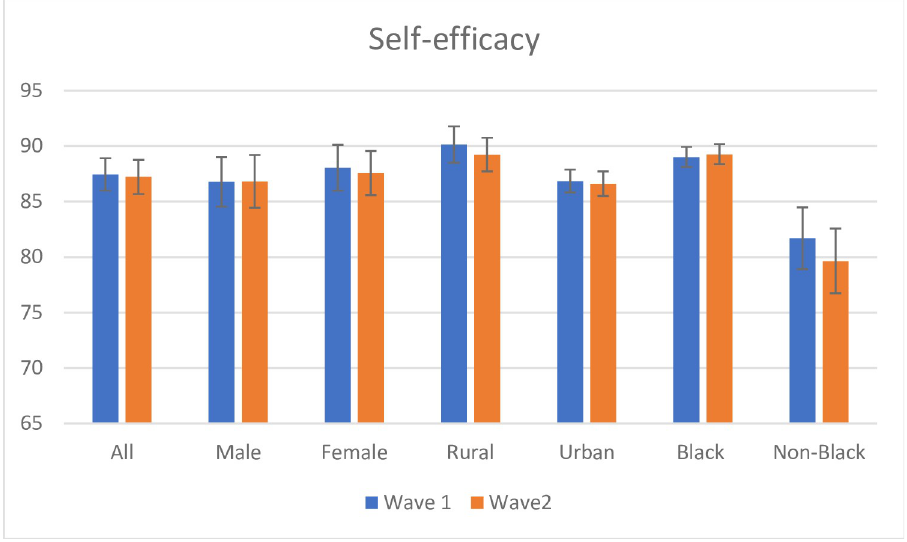
Fig 5. Self-efficacy across Wave 1 and Wave 2. Source: NIDS-CRAM, Wave 1 (2020) and NIDS-CRAM, Wave 2 (2020). Data are weighted. The bars show the reported self-efficacy. 95% confidence intervals are shown.